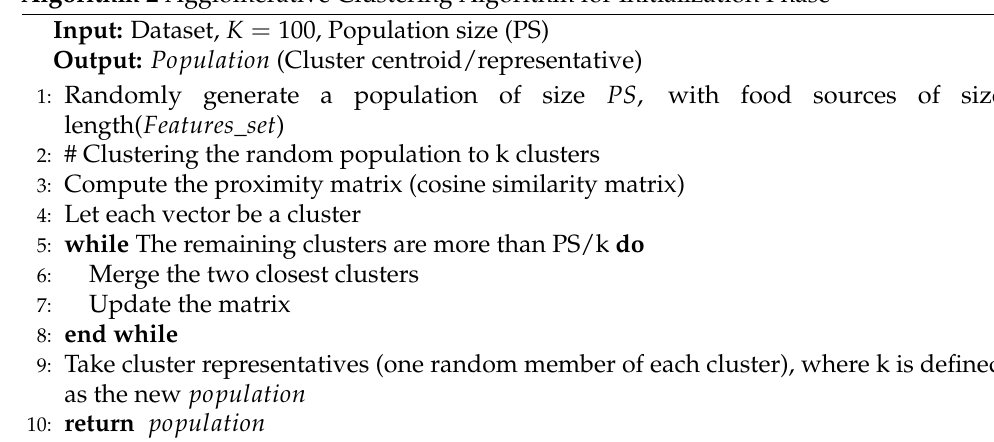
Algorithm 2 Agglomerative Clustering Algorithm for Initialization